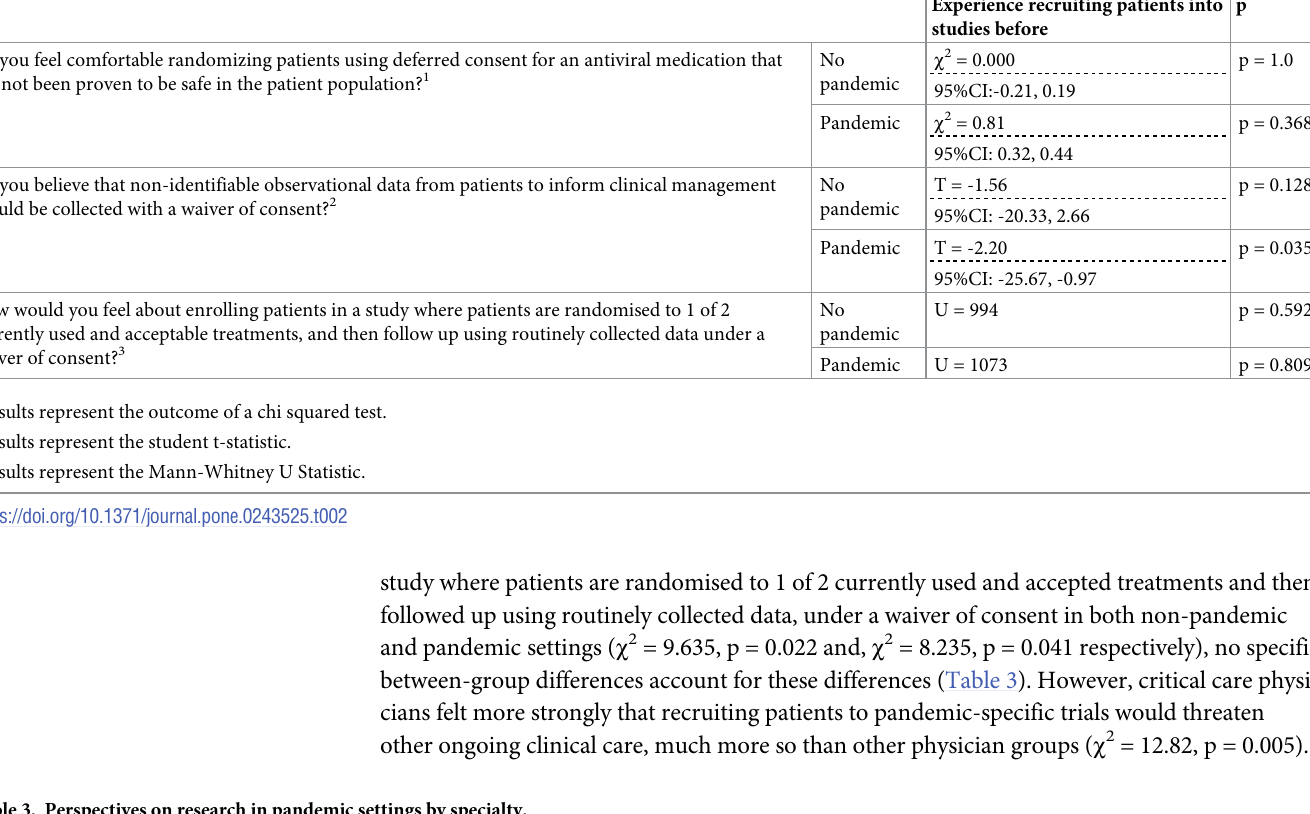
Experience recruiting patients into studies before